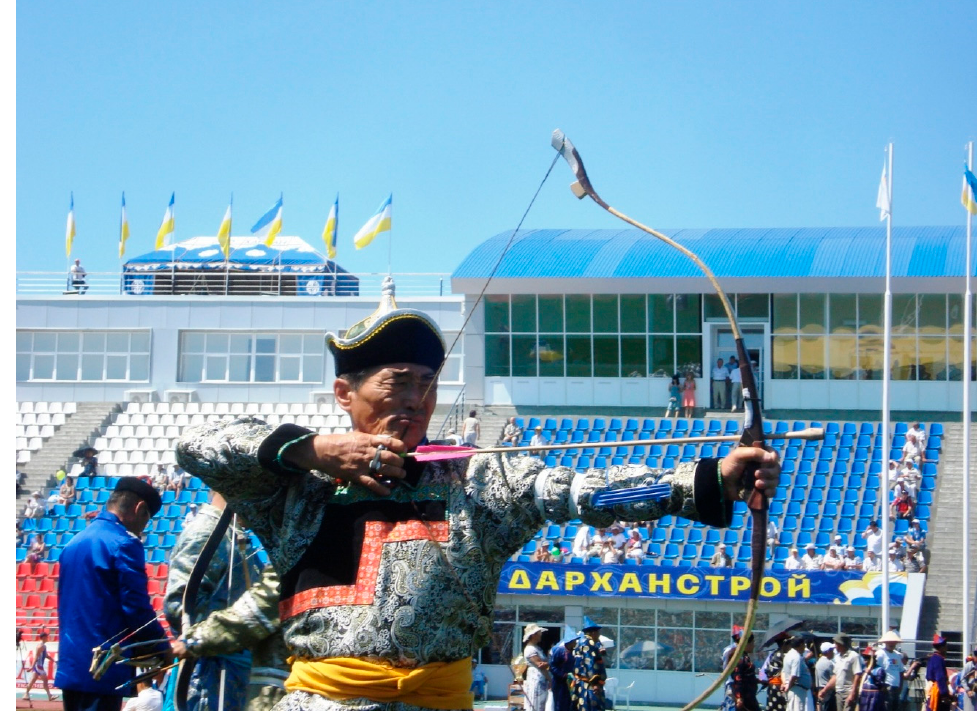
Figure 2. Buryat archer at the Republic Surkharban Festival in the central stadium of Ulan-Ude, the capital of the Republic of Buryatia of the Russian Federation in summer 2015. Photo: Stefan Krist.